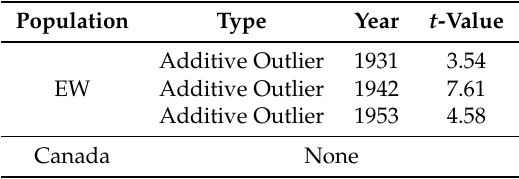
Table 1. Detected additive outliers in the time-varying parameter